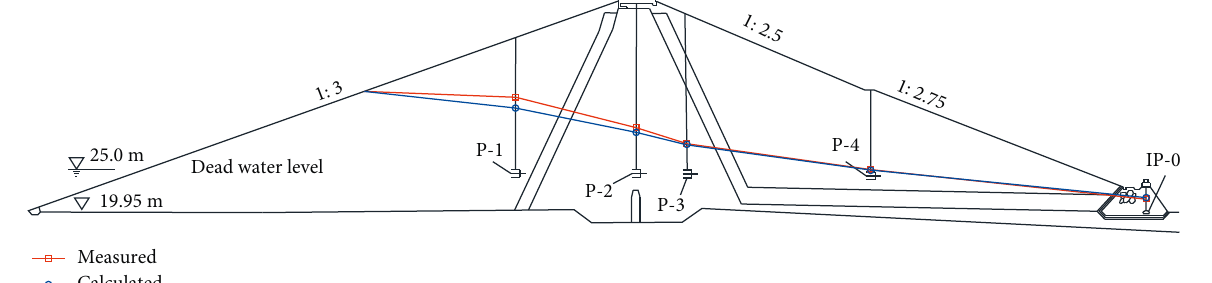
Figure 3: Measured and calculated phreatic line of the dam.